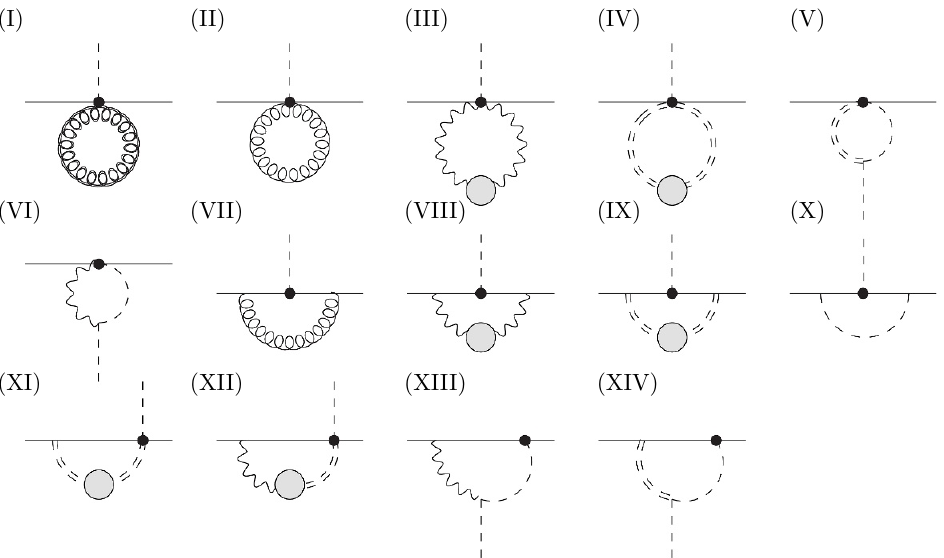
Figure 2 . The loop corrections to the Yukawa coupling. The Feynman diagrams for the propagators are shown in (cid:12)gure